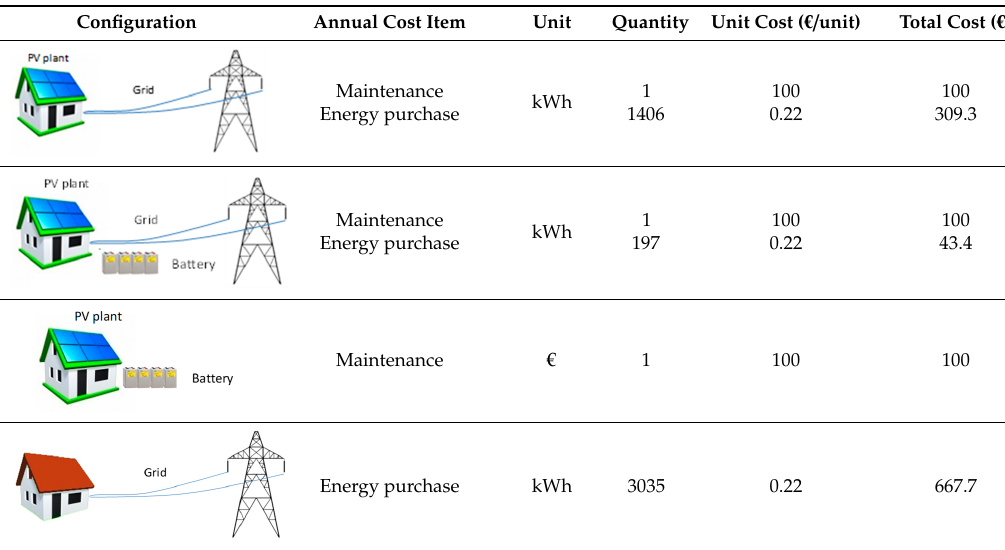
Table 4. Annual operating costs.